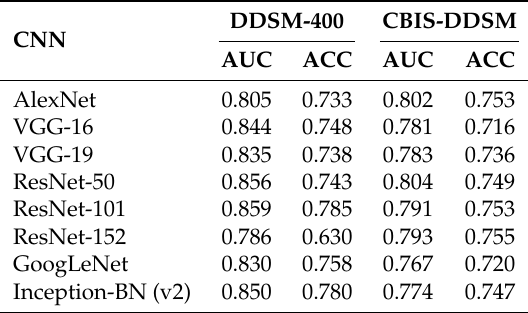
Table 3. Performance of convolutional neural networks (CNNs) initialized on pre-trained weights